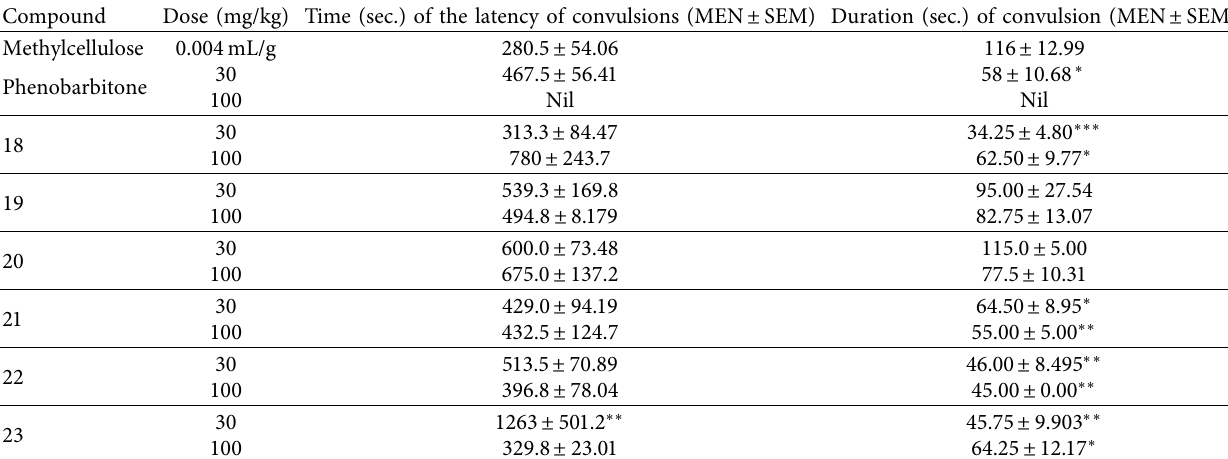
Table 2: Effect of the synthesized compounds on latency and duration of PTZ-induced seizure. Compound